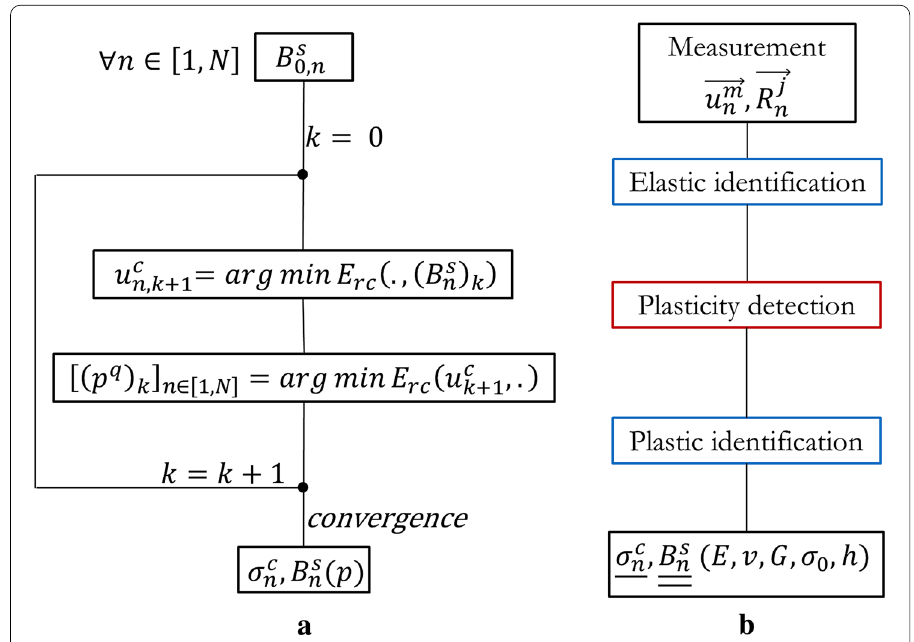
Fig. 1 a Example of E rc minimization algorithm used for the step (i) and step (iii), b global identification